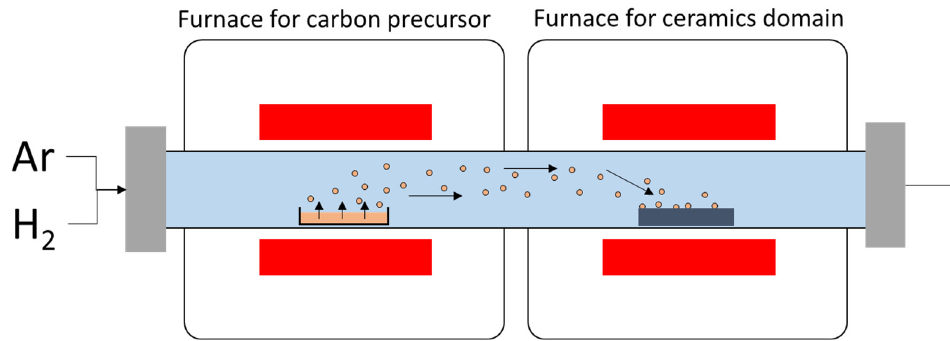
Figure 7. In situ processing of CNTs-CMCs by thermal chemical vapour deposition (CVD).